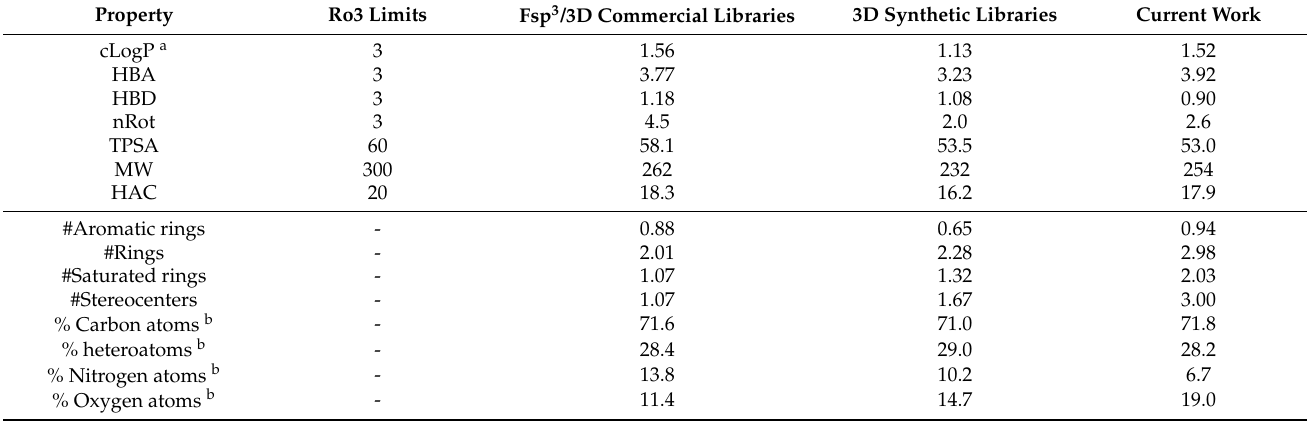
Table 2. Calculated properties. Average mean values for the properties of commercial “Fsp 3 ” and “3D” fragment libraries extracted from a recent review [39], 25 papers disclosing synthetic 3D fragment sets [40], and the 100 compounds of the current paper. (Top) The “rule of three” physicochemical parameters supplemented with HAC; (Bottom) Additional structural parameters. Values were calculated with KNIME software on the neutral chemical